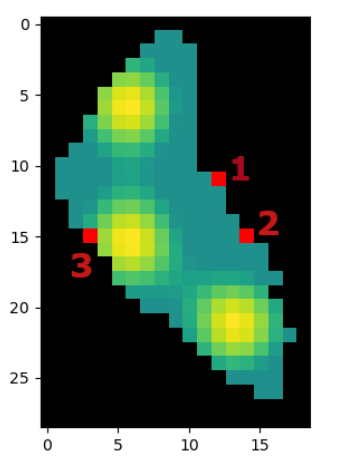
Figure 18. Different initial points (red) in the N = × 2 resolution map. Each ASV is assigned with one specific initial point, so the order in the EA chromosomes and each output layer of DRL will be the same from a generation/episode to